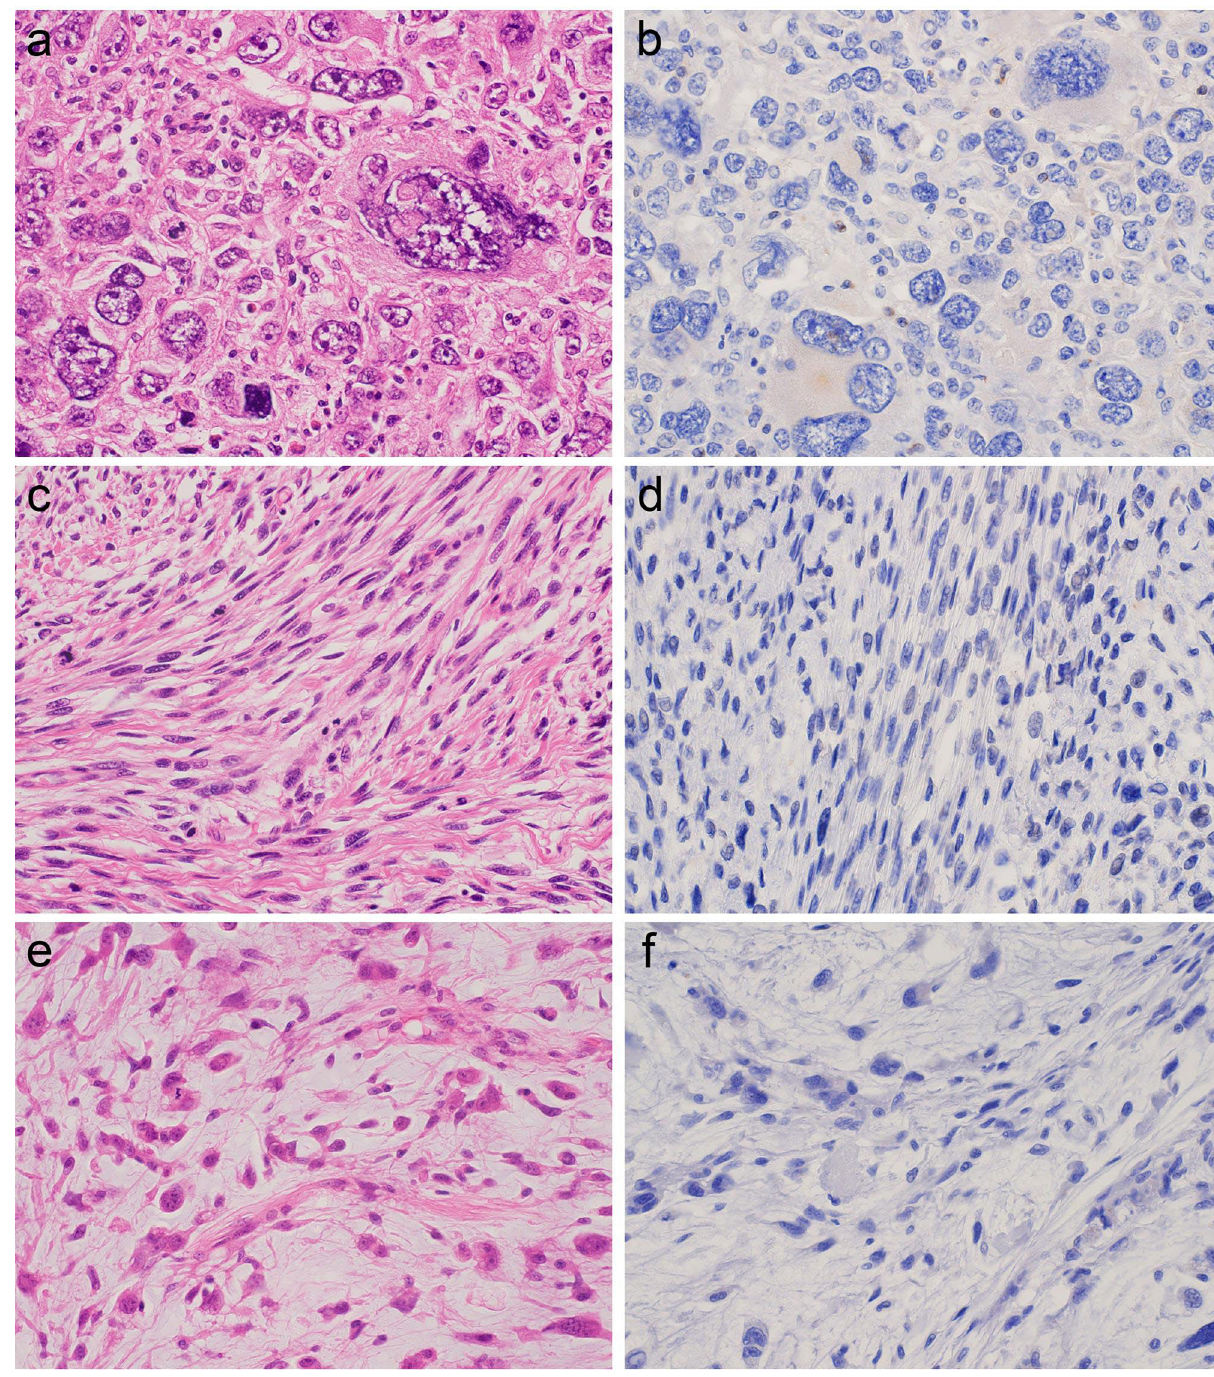
Fig. 4 Histology and CSF1 IHC of undifferentiated pleomorphic sarcoma, leiomyosarcoma, and myxofibrosarcoma a. Undifferentiated pleomorphic sarcoma showed a solid proliferation of atypical spindle to pleomorphic cells with marked nuclear atypia and nuclear pleomorphism b. The tumor cells were negative for